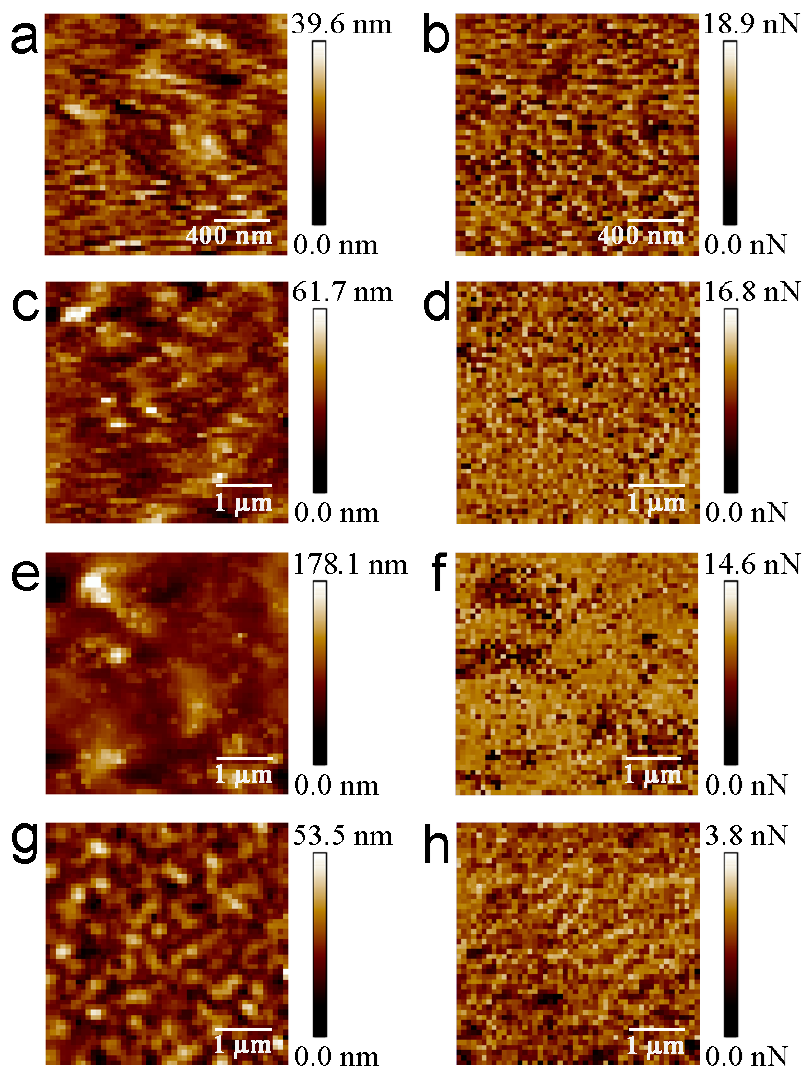
Figure 3. Force–volume experiments between PBS functionalized tips and CNCs ( a , b ), GMK ( c , d ), XYL ( e , f ), and LIG ( g , h ). Topography and force maps are represented on the left and right side, respectively.